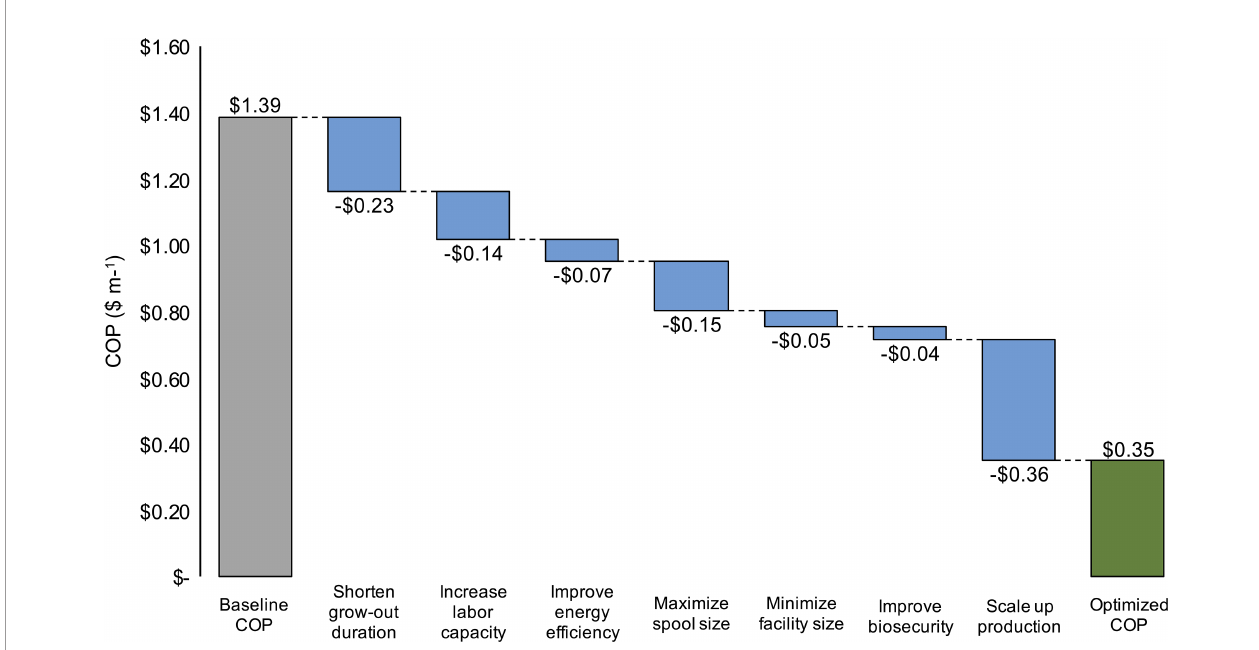
FIGURE 7 | Hypothetical decreases in baseline production costs ($ m -1 ; COP) as a result of a shortened grow-out duration (days), increase in labor capacity (m of twine per FTE employee), reduction in grid electricity costs ($ kWh -1 ), 100% increase in spool size, reduction in facility construction costs ($ m -2 ), reduction in product loss (% total -1 ), and increase in scale (>1,200 km of twine). The “ Optimized COP ” value depicts the sum of all process